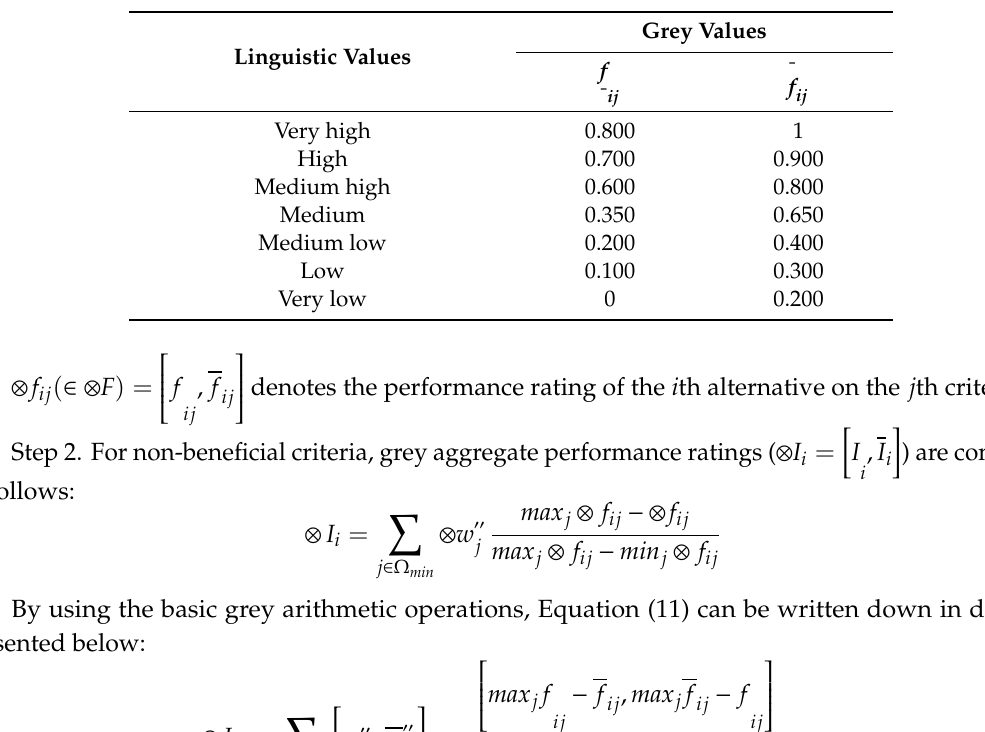
Table 3. The linguistic and grey values for performance rating